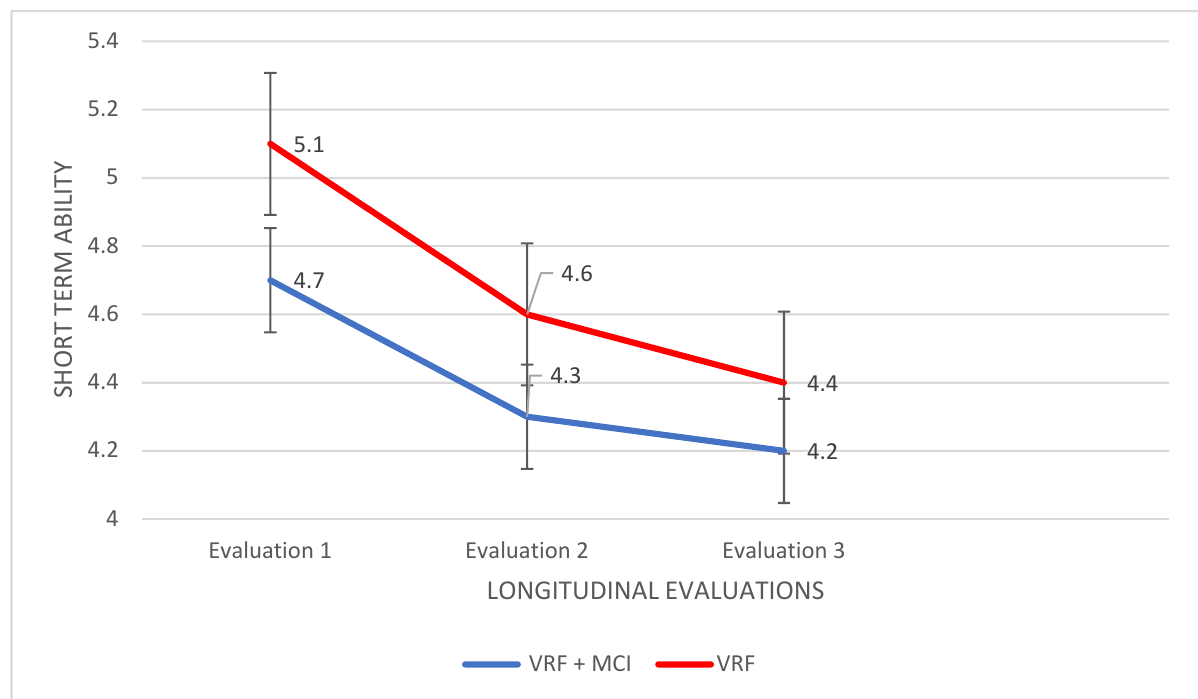
Figure 4. Performance of adults with VRF and adults with VRF + MCI in the Forward condition (short ‐ term memory) of Digit Span Test.